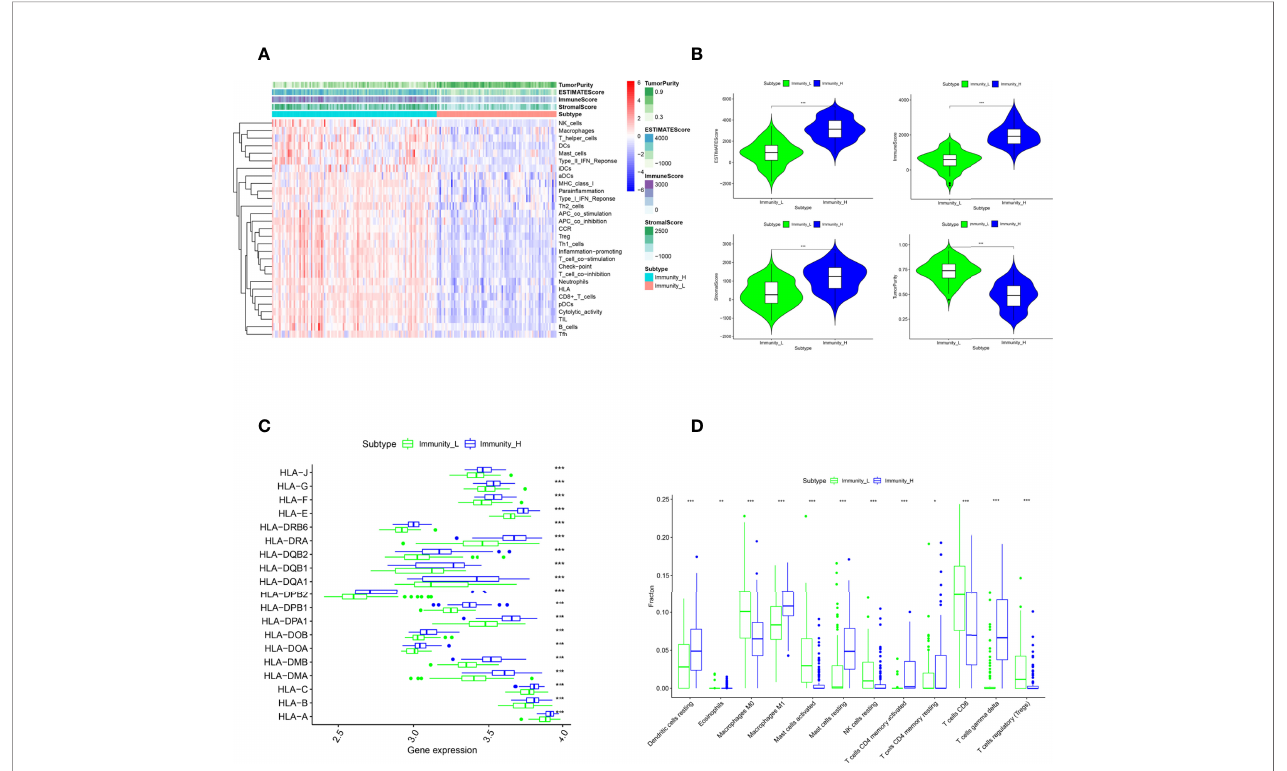
FIGURE 1 | Patient classi fi cation by immune cell in fi ltration. (A) . The ssGSEA divided patients into Immune Cell Pro fi ciency (ICP) group and Immune Cell De fi ciency (ICD) group. The Tumor Purity, ESTIMATE Score, Immune Score, and Stromal Score of each sample gene were also displayed. (B) . The difference in Tumor Purity, ESTIMATE Score, Immune Score, and Stromal Score between the two groups. (C) The expression of HLA family genes in the two groups. (D) The immune cell in fi ltration fractions in the two groups caculated by the CIBERSORT algorithm. *P < 0.05, **P < 0.01, and ***P < 0.001 were considered statistically signi fi